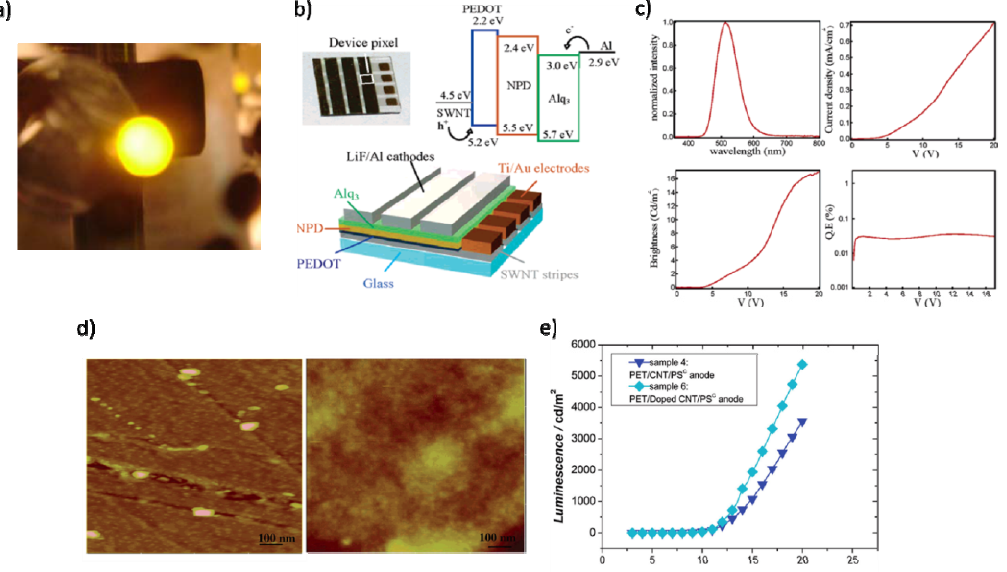
Figure 2. ( a ) Photograph of an OLED that uses an multi-wall nanotube (MWNT) sheet as the anode and poly(3,4-ethylenedioxythiophene) poly(styrenesulfonate) (PEDOT:PSS)/ Poly[2-methoxy-5-(2-ethylhexyloxy)-1,4-phenylenevinylene] (MEH-PPV) /Ca/Al [13]; ( b ) patterned multilayer single wall CNT/PEDOT:PSS/NPB/Alq /LiF/Al [20]; ( c ) device 3 performance: photoluminescence spectrum, current density vs. voltage bias curve, brightness vs. voltage bias and quantum efficiency as a function of current density [20]; ( d ) surface roughness of PEDOT:PSS ~4 nm and methanol-modified PEDOT:PSS ~0.96 nm on a CNT network [21]; ( e ) the luminescence vs. the voltage of an OLED with PEDOT:PSS composite (PS C )-modified CNT on Polyethylene terephthalate (PET) substrate